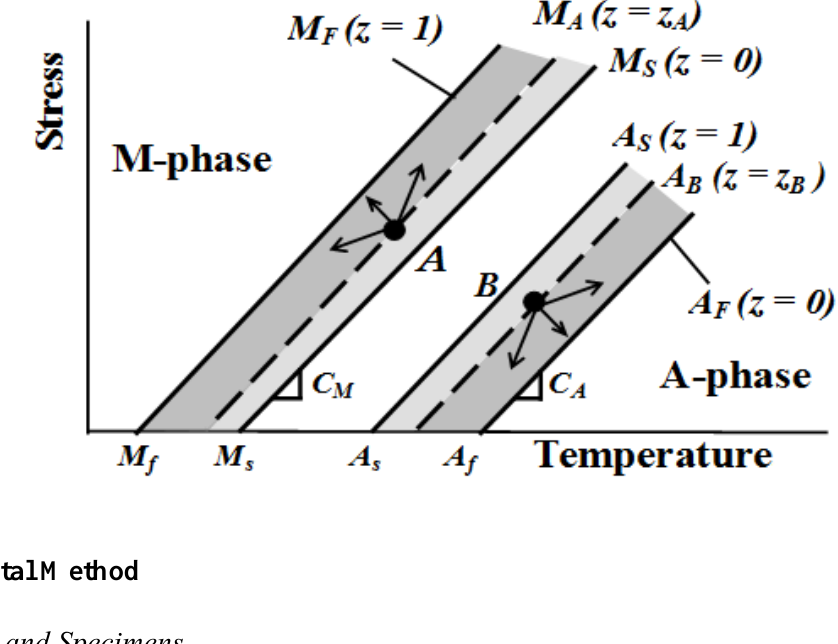
Figure 1. Conditions for progress of the martensitic transformation (MT) and the reverse transformation in the subloop loadings on the stress-temperature phase